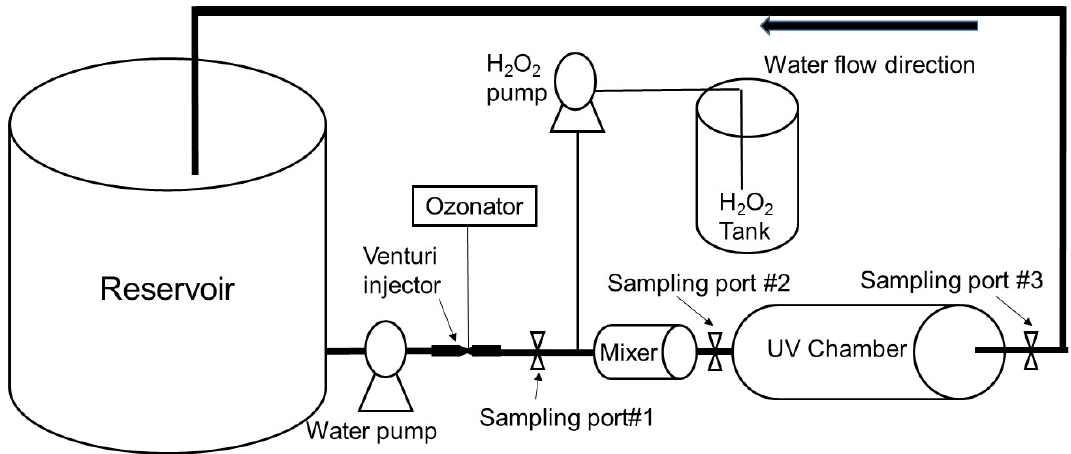
Figure 1. A schematic of a field pilot-scale UV / H 2 O 2 system being composed of an of high-density polyethylene (HDPE) reservoir, an electrical water pump, an H 2 O 2 peristaltic pump, an H 2 O 2 storage tank, and a Trojan UV unit.